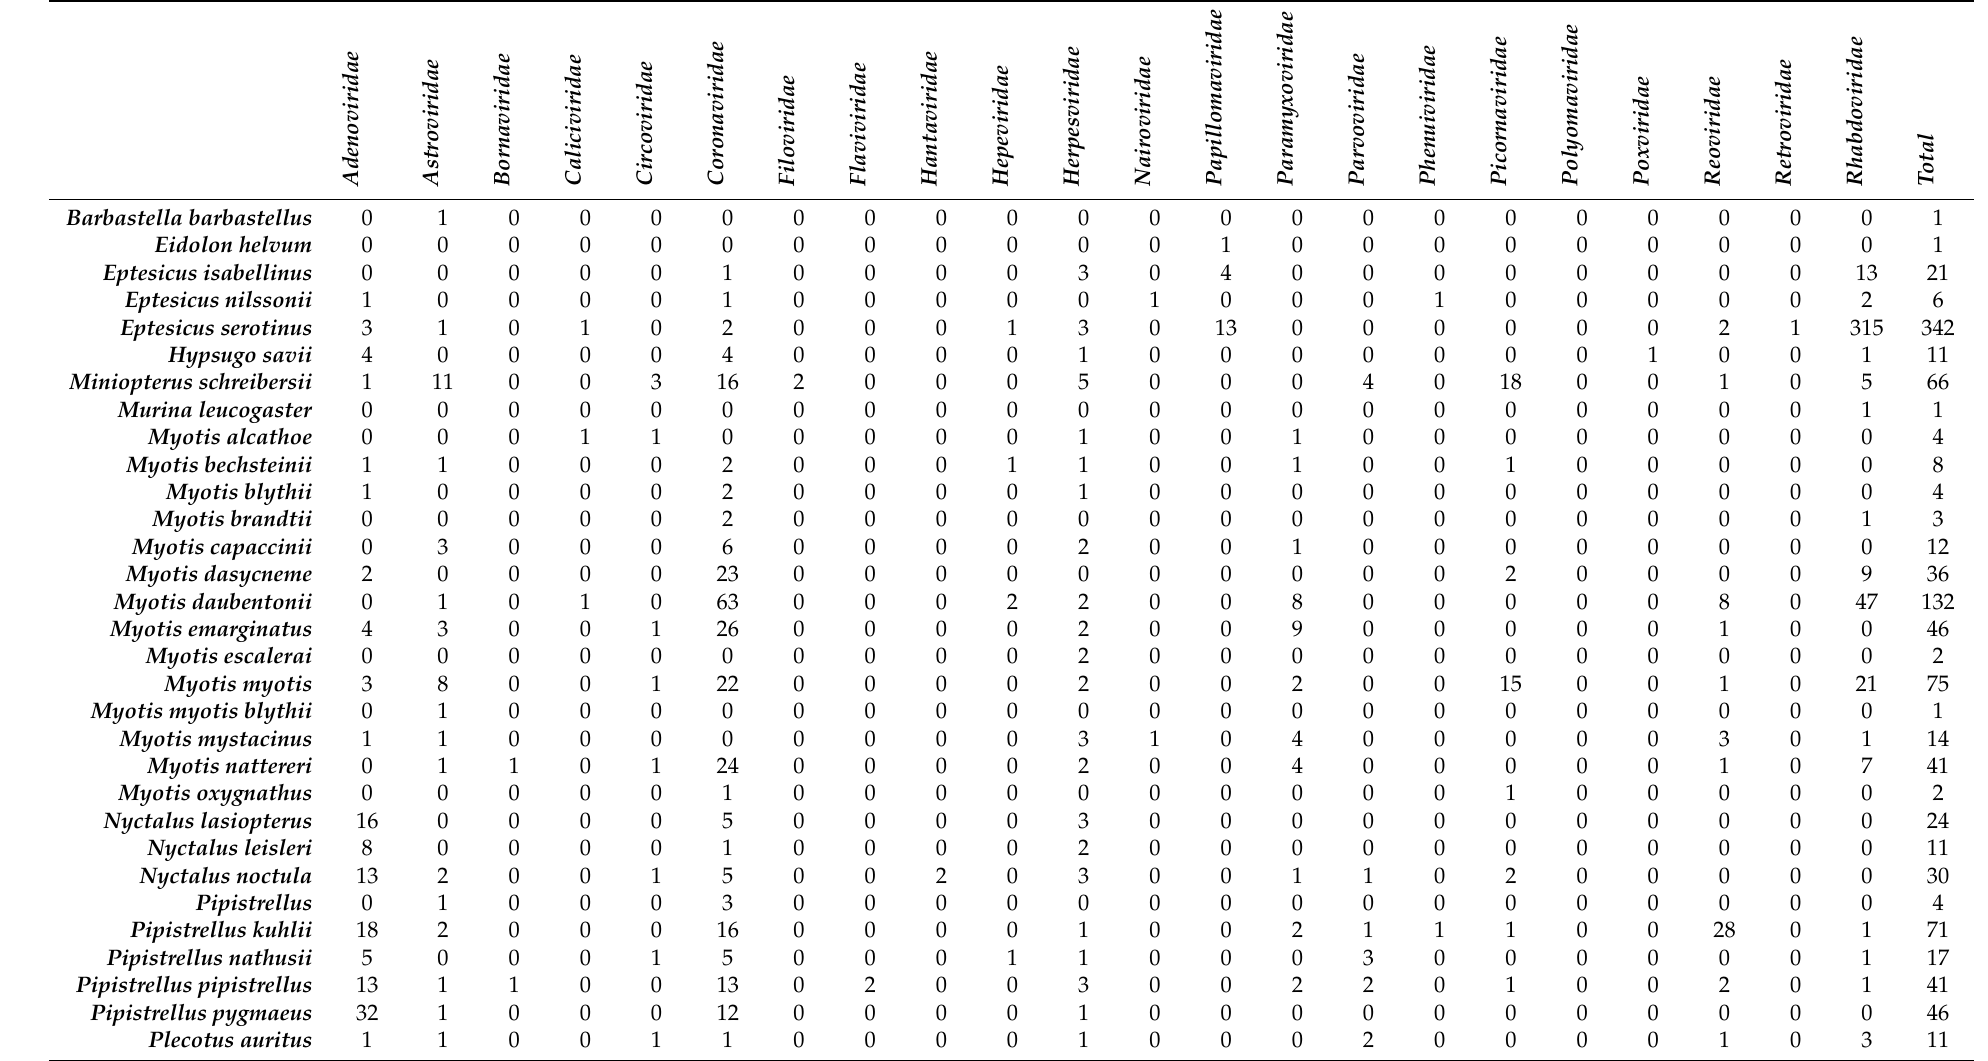
Table 1. Overview on virus data per bat species recorded at DBatVir